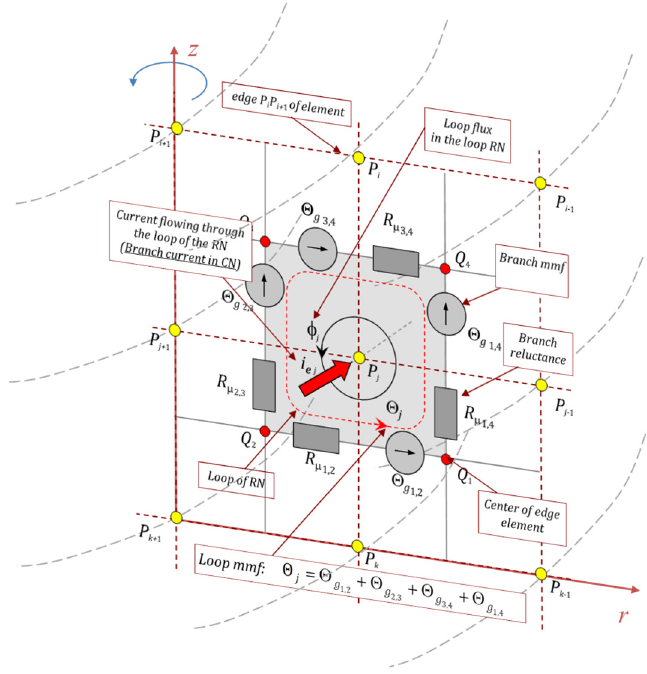
Figure 4. 2D representation of the reluctance network (RN) for an axial symmetry system .